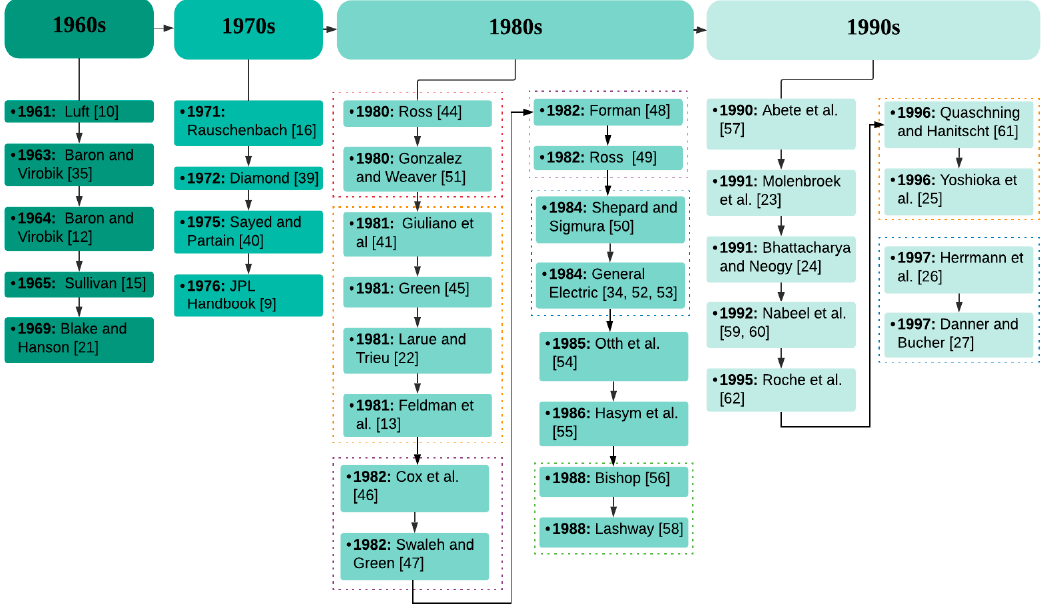
Figure 7. Main references through the 1990s.